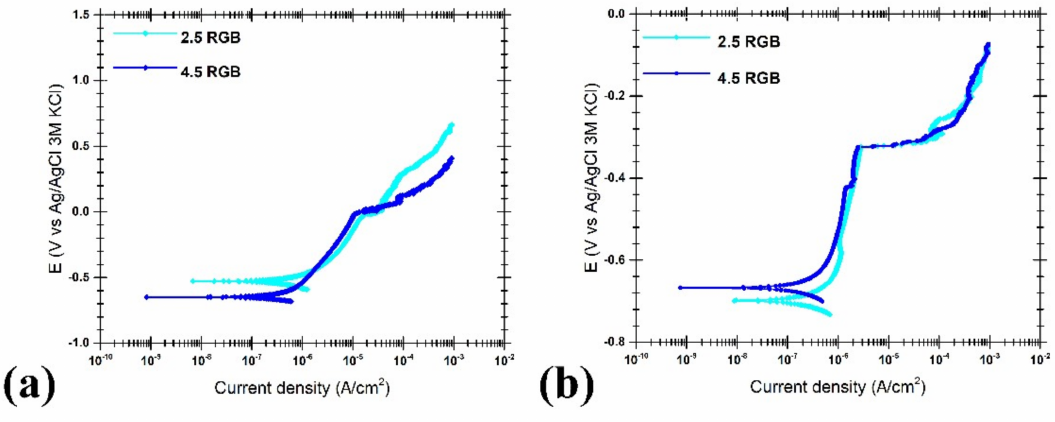
Figure 10. Potentiodynamic polarization curves in ( a ) the solution of 3.5 g/L (NH 4 ) 2 SO 4 and ( b ) the diluted Harrison solution.